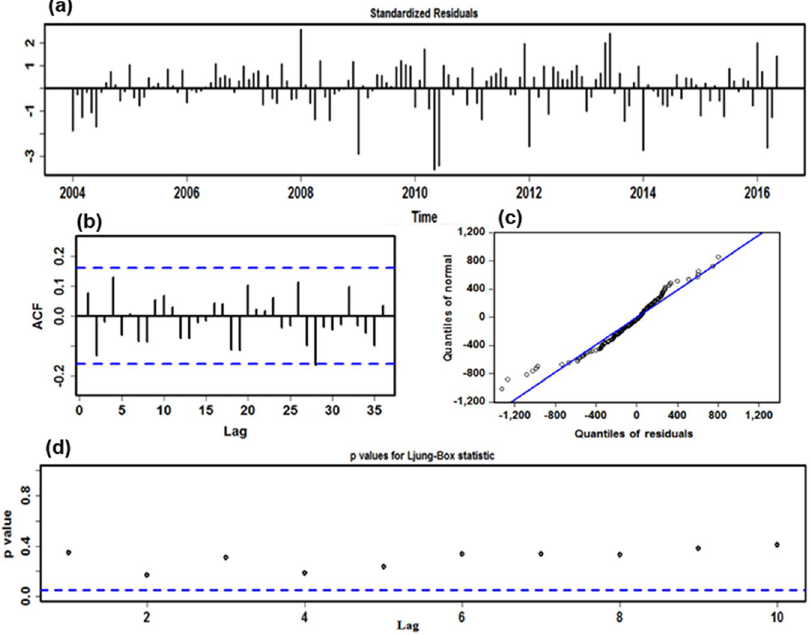
Figure 5. Residual diagnostic plots of hybrid ARIMA-ETS model. ( a ) Standardized residuals. ( b ) Autocorrelation function (ACF) plot of the time-series residuals. ( c ) Normal Q-Q plot for determining the normality of the time- series residuals. ( d ) P values for Ljung-Box statistic. Based on the plots, it can be found that the residuals seem to be well modeled as white noise, so this proposed hybrid approach is appropriate for fitting the data.